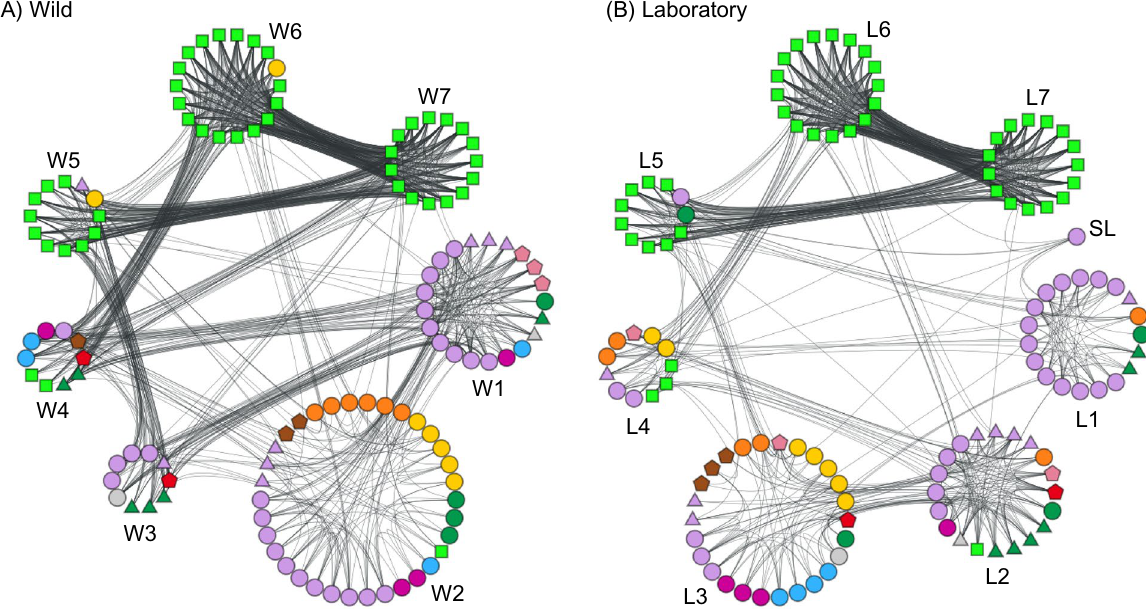
Figure 2. Community structure of the (A) wild and (B) laboratory mouse network, with the seven communities within each (W1–W7 and L1–L7), and the additional single (SL) node in the laboratory mouse network. Nodes in both networks are coded as Fig. 1A, and fully labelled networks are shown in Supplementary Fig.